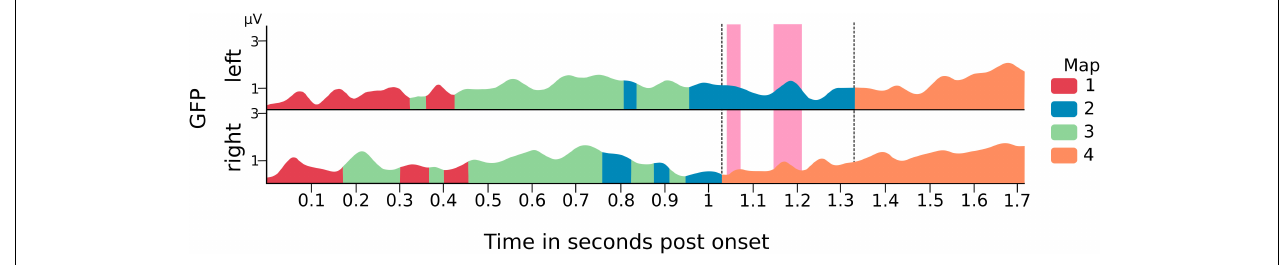
FIGURE 4 | Backfit of the prototype maps on the group CSERPs global field power (GFP) of each condition with fitted maps. Pink marks highlight significant time intervals of the TANOVA results on GMD. Dotted black line encloses the time window used based thereupon for the subject-level backfit.